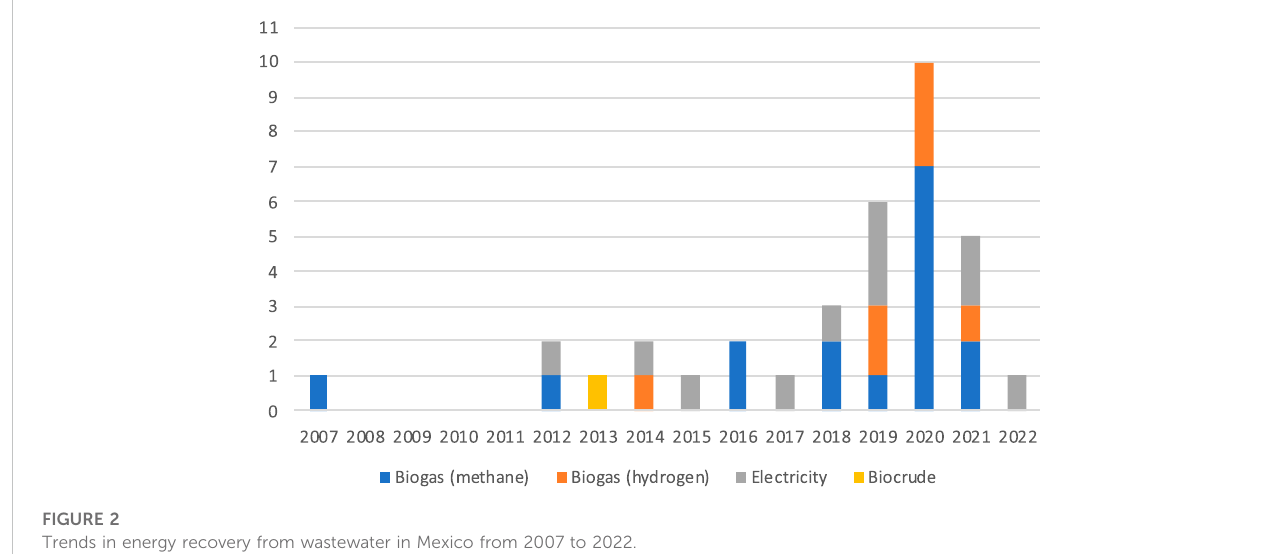
FIGURE 2 Trends in energy recovery from wastewater in Mexico from 2007 to